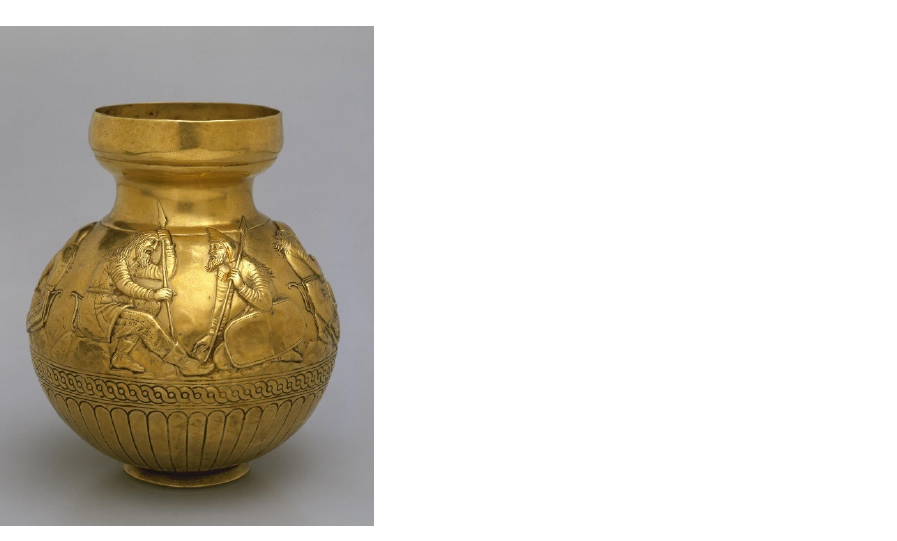
Figure 26. Vessel with lion hunting scenes (SHM inv. no. Дн .1913 ‐ 1/40); silver and gilt silver; Kurgan 2, Solokha, Dnepropetrovsk region, Ukraine; early 4th century BC. [Image is used from www.hermitagemuseum.org (accessed 9 November 2022), courtesy of the State Hermitage Museum, St. Petersburg, Russia]. Most of these items seem to have been made by Greek craftsmen, or at least by metalworkers intimately acquainted with and highly skilled in Greek artistic and manufacturing techniques. Stylistically and in the technical quality of their manufacture they are quite unlike most other Scythian art and resemble the finest Greek work, and if not explicitly concerned with classical subjects, they all show the influence of classical